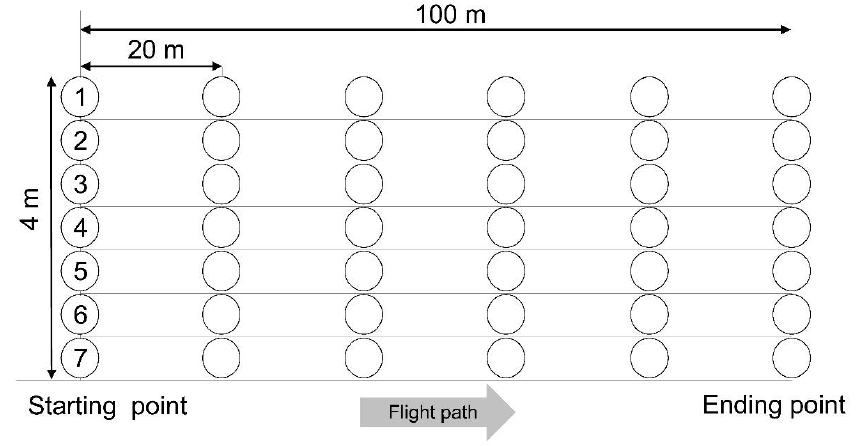
Figure 6 . Sampling points in a test plot for the investigation of residual distribution on pre-harvest day.